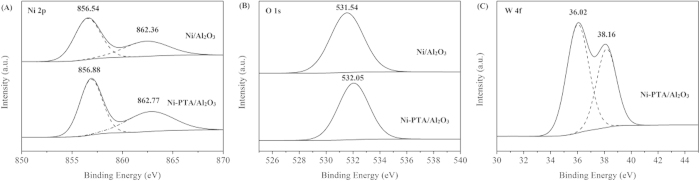
XPS spectra of (a) Ni 2p, (b) O 1s and (c) W 4f levels of the synthetic Ni/Al2O3 catalyst and the synthetic Ni-PTA/Al2O3 catalyst.